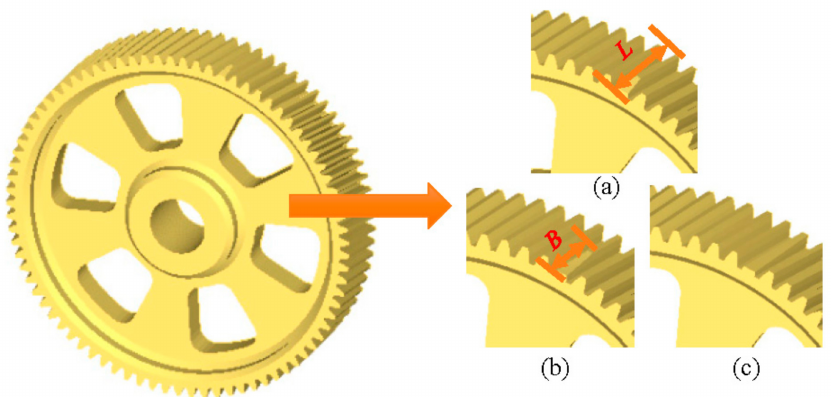
Figure 6. The degree of tooth breakage, ( a ) 1 / 3 breakage, ( b ) 2 / 3 breakage, and ( c ) total breakage.